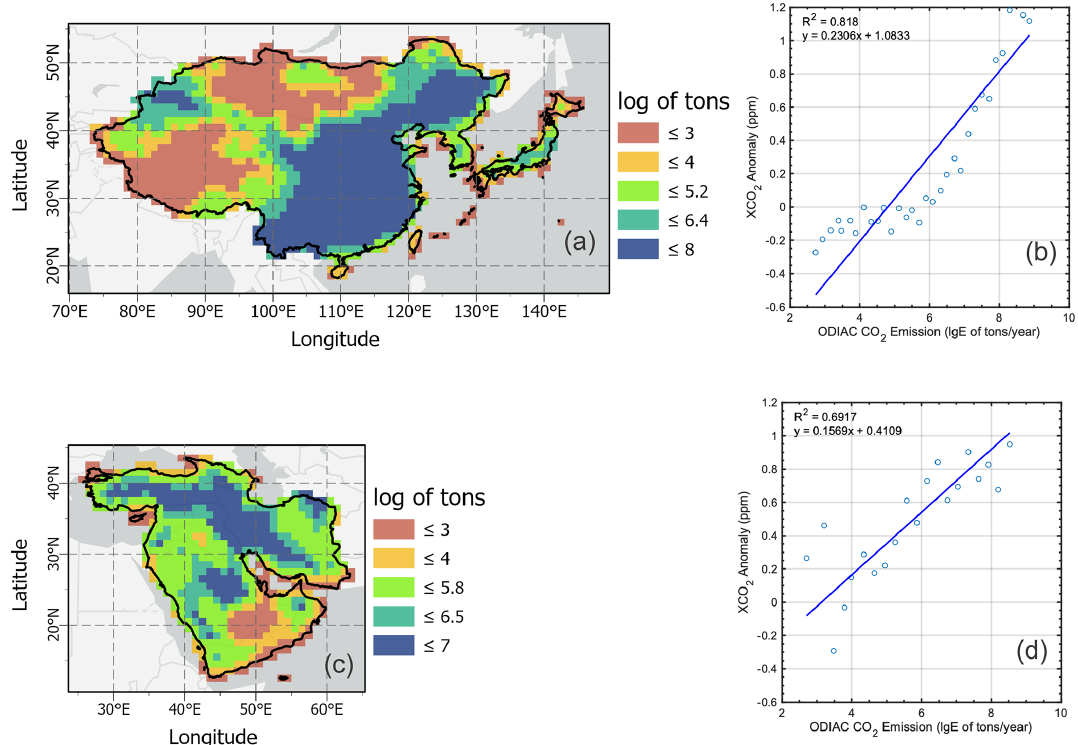
Figure 6. The spatial distribution of segmented ODIAC emissions, where the data are binned in 0.3tyr − 1 of lgE (logarithm of base 10) bins using the mean emission calculated from the annual emissions from 2015 to 2019 over (a) East Asia and (c) West Asia. The correlation between mean ODIAC CO 2 emissions and mean XCO 2 anomalies calculated from annual XCO 2 from 2015 to 2018 for (b) East Asia and (d) West Asia. (The base map was sourced from